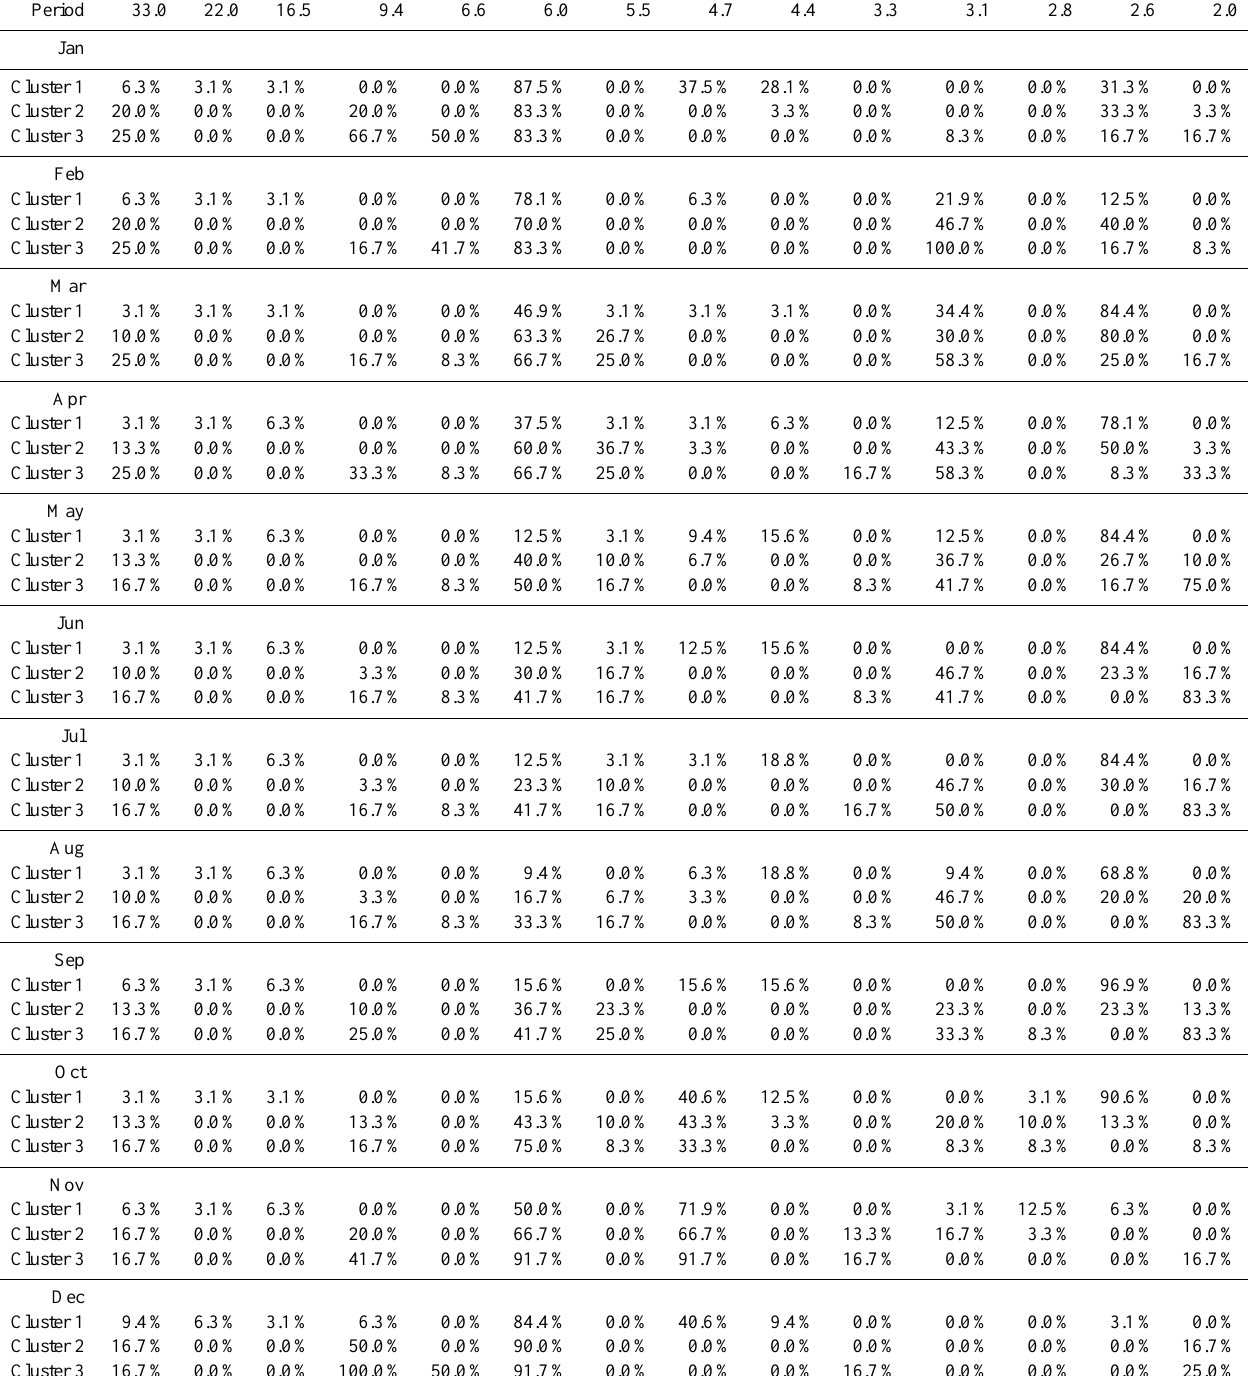
Table A1. Frequency of the cycles (%) relative to the number of series included in each cluster (just the significant cycles of the peri-